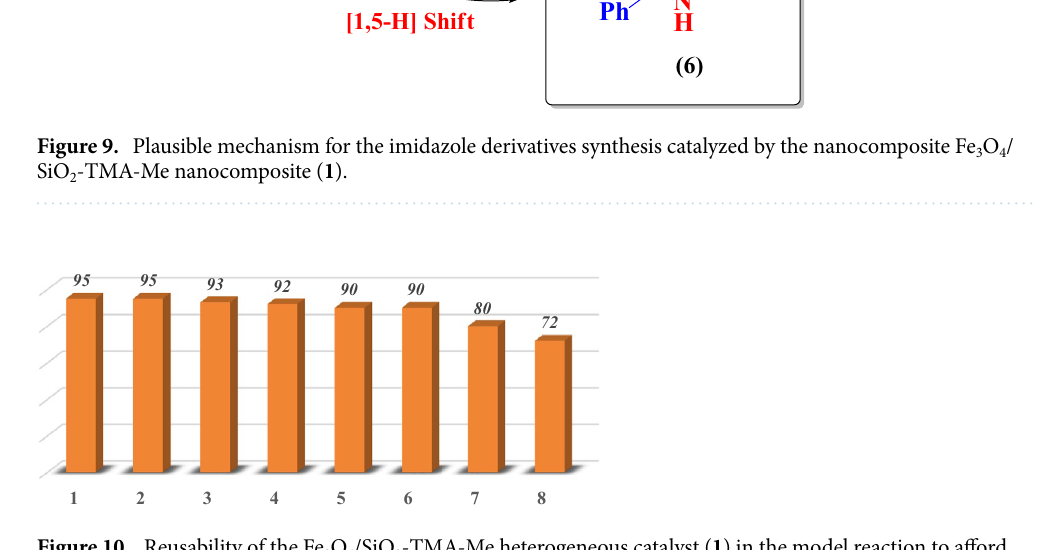
Figure 10. Reusability of the Fe 3 O 4 /SiO 2 -TMA-Me heterogeneous catalyst ( 1 ) in the model reaction to afford 6a